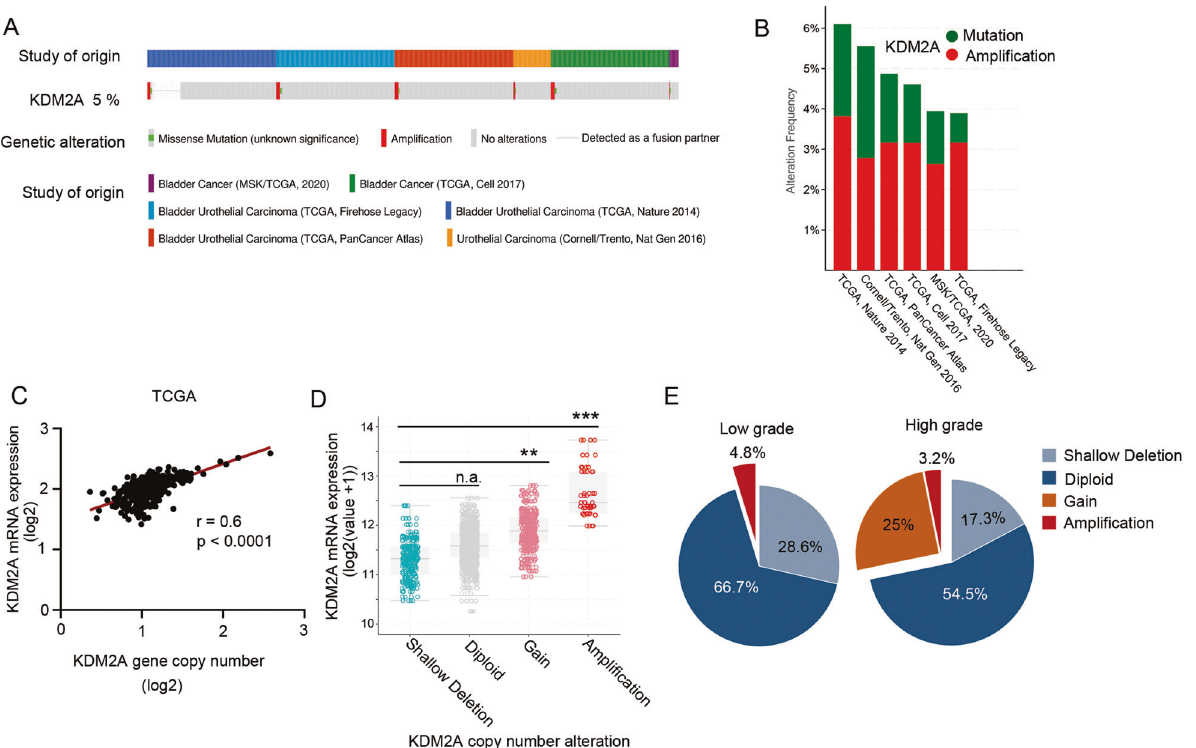
Fig. 1 KDM2A gene copy number gain contributed to KDM2A mRNA upregulation in bladder cancer. A The OncoPrint tab summarizes KDM2A genomic alterations in six sample sets. Each column represents a tumor sample, red bars indicate gene ampli fi cations, blue bars are homozygous deletions, and green squares are missense mutations (http://www.cbioportal.org/). B Further analysis of KDM2A alterations in each of the studies. C KDM2A mRNA expression was positively correlated with KDM2A gene copy number alteration (r = 0.6, P < 0.0001, linear regression). D KDM2A gene copy number gain and ampli fi cation were positively correlated with increased mRNA expression in TCGA bladder cancer cohort. E TCGA gene copy number data showed a higher ratio of gain and ampli fi cation alterations detected in high-grade bladder cancer than in low-grade samples (high-grade, 28.2%; low-grade, 4.8%). * P < 0.05; ** P < 0.01; *** P < 0.001 is based on the Student ’ s t test. All results are from more than three independent experiments. Values are mean ±